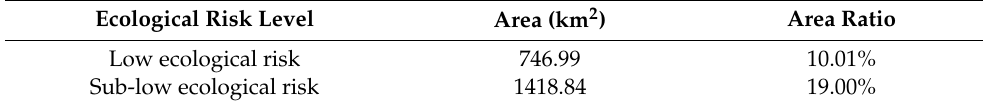
Table 3. Landscape ecological risk level area and